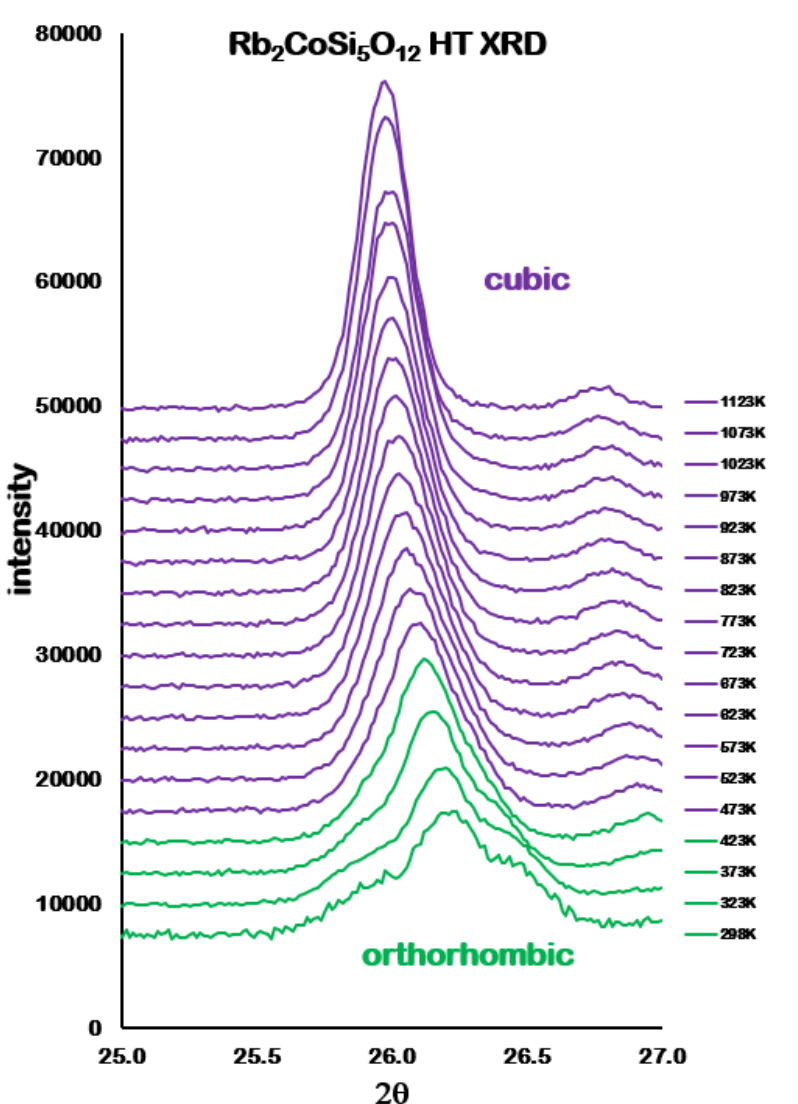
Figure 4. Plot showing XRD data for Rb 2 CoSi 5 O l2 25–27 ◦ 2 θ over the temperature range 298–1123 K. This shows how three closely overlapped 004, 040 and 400 Pbca orthorhombic Bragg reflections (green) merge to form a single 𝑃𝑎 3 cubic 400 Bragg reflection (purple) on heating.